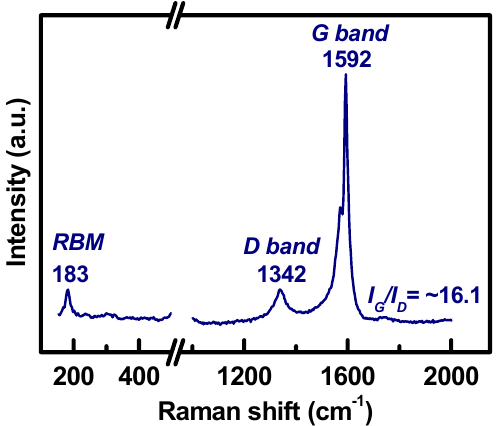
Figure 4. Raman spectrum of the as-grown SWCNTs networks.